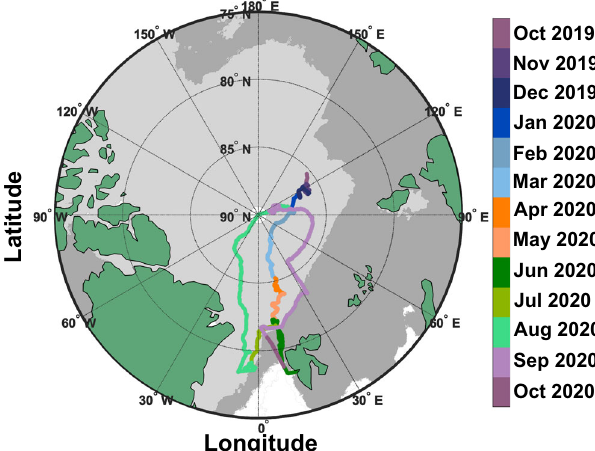
Fig. 1 Map of Polarstern location during the Multidisciplinary drifting Observatory for the Study of Arctic Climate (MOSAiC) expedition. The ship track is colored by date. Only dates that involved ice nucleating particle (INP) sample collection are shown. Dark and light gray shaded areas represent the maximum and minimum sea ice extent (sea ice concentration ≥ 15%) in March and September 2020, respectively. Maps were created by the authors using MathWorks MATLAB